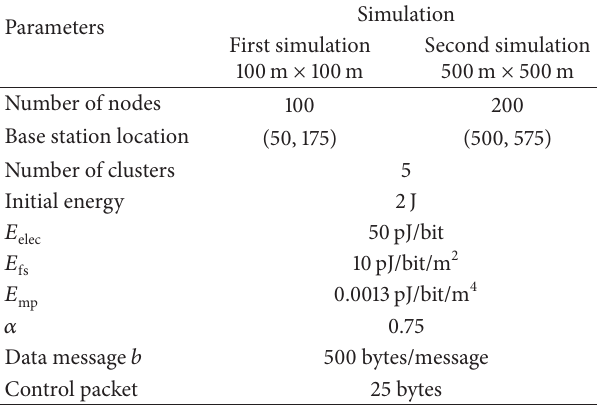
Table 1: The settings for each